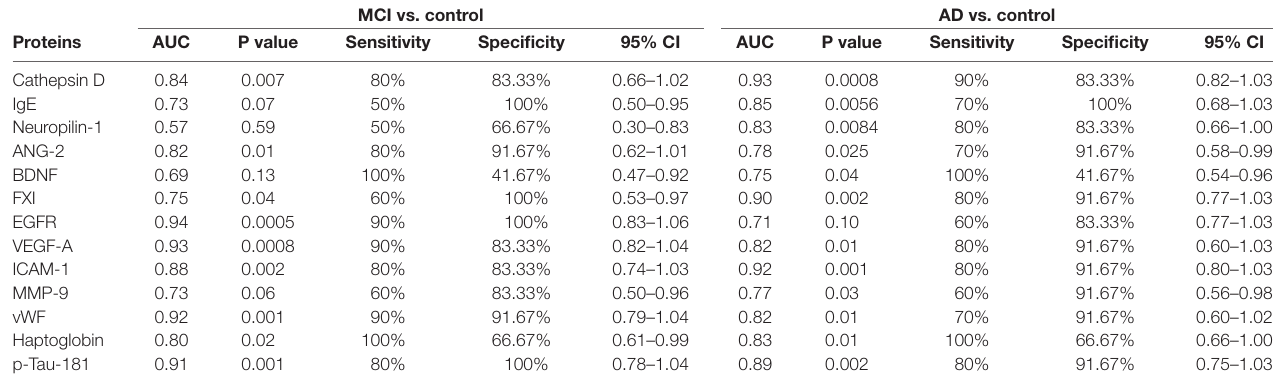
TABLE 2 | Outcomes of the receiver operating characteristic curve analysis for the identified proteins. MCI vs. control